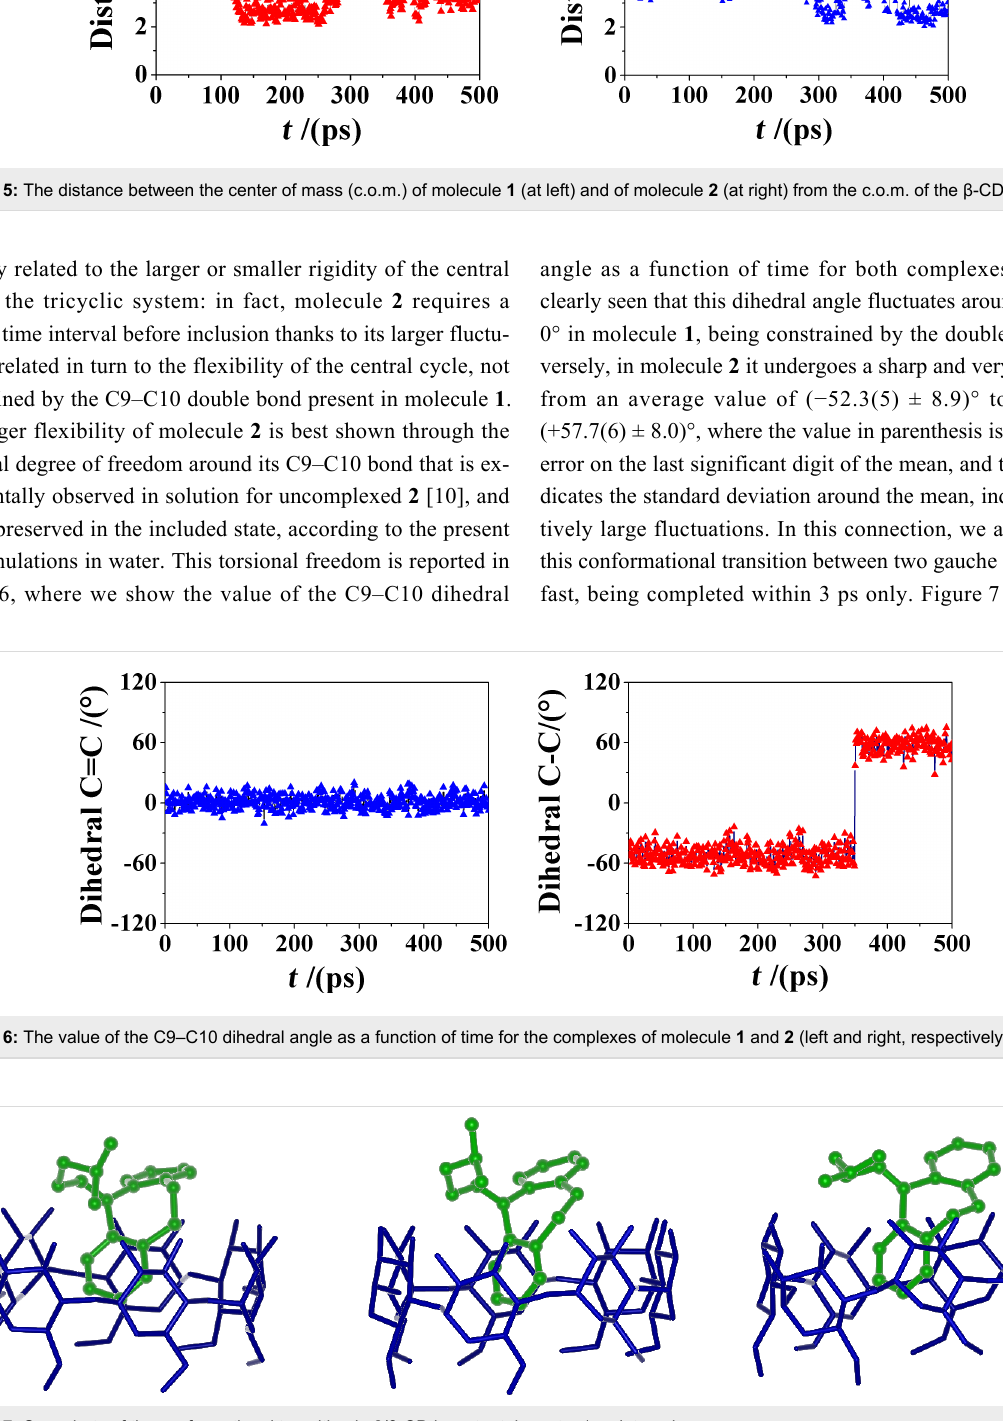
Figure 7: Snapshots of the conformational transition in 2 / β -CD in water taken at a 1 ps interval.